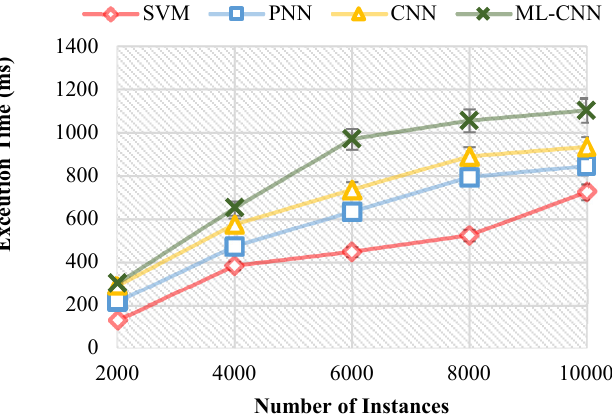
Figure 12. Execution time vs. number of instances.